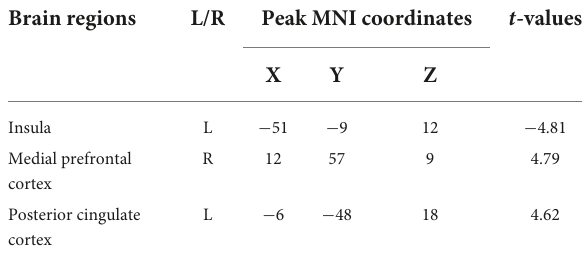
TABLE 2 Regions with changed association index (Asso) and functional connectivities (FC) in patients with Alzheimer’s disease compared to healthy